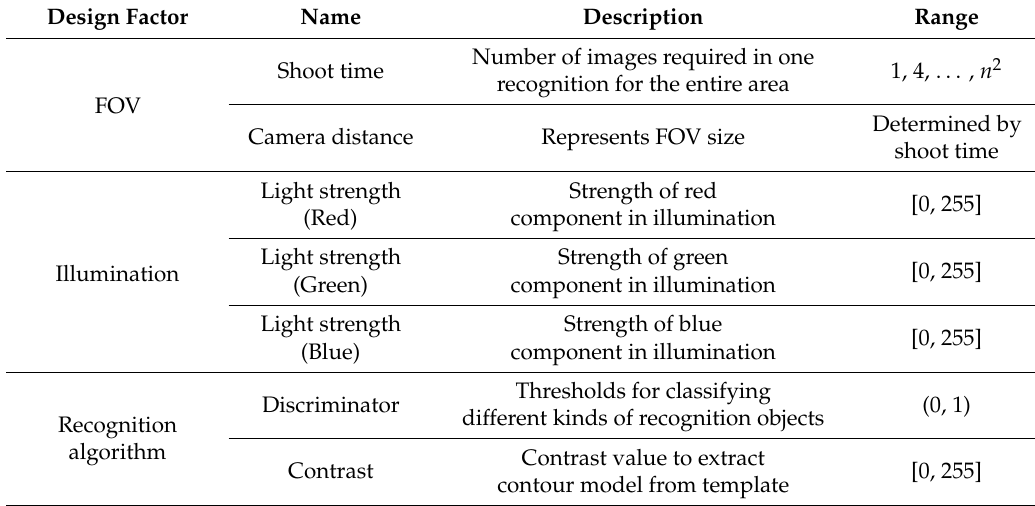
Table 1. List of design